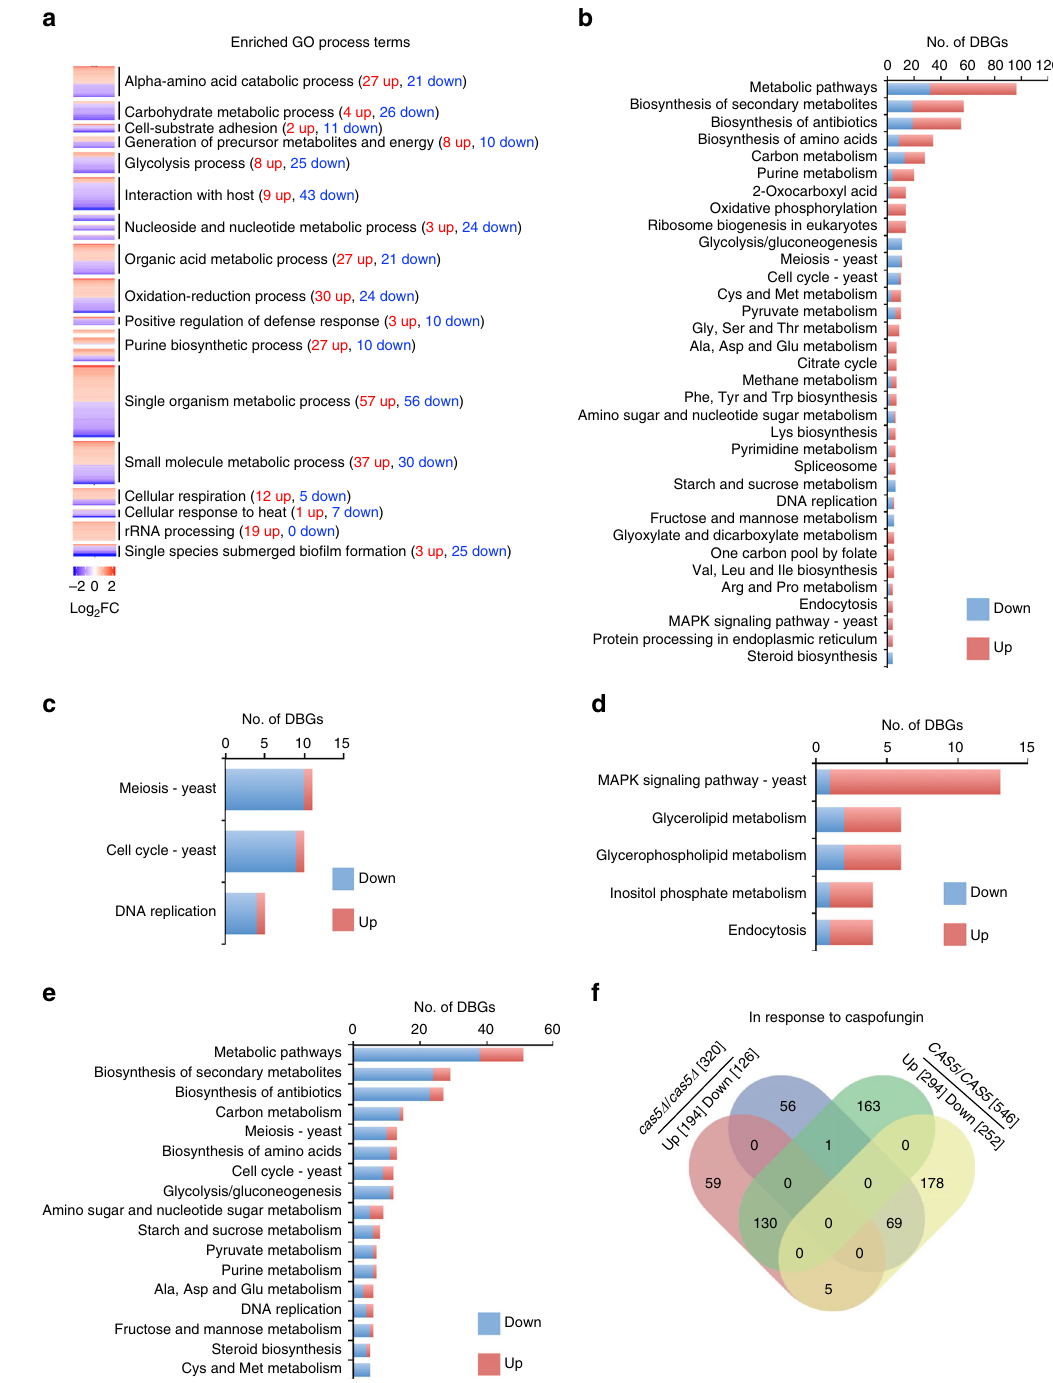
Fig. 1 Cas5 has a profound impact on RNA PolII binding at genes implicated in cell wall and cell cycle processes under both basal and cell wall stress conditions. a Heat maps showing the genes with increased ( red ) and decreased ( blue ) RNA PolII binding in a cas5 Δ /cas5 Δ mutant relative to wildtype. Enriched GO processes are indicated, and were clustered using the DAVID Gene Functional Classi fi cation Tool. b Bar chart showing the number of genes differentially bound by PolII ( DBGs differentially bound genes), with increased binding in red and decreased binding in blue , in a cas5 Δ / cas5 Δ mutant relative to wildtype based on their assigned KEGG pathways. KEGG pathways with four or more genes assigned are shown. c Bar chart showing the number of genes differentially bound by PolII, with increased binding in red and decreased binding in blue , in a cas5 Δ / cas5 Δ mutant relative to wildtype belonging to select KEGG pathways involved in cell cycle and related processes. d , e Bar charts showing the number of differentially bound genes involved in the indicated physiological pathways upon caspofungin treatment, with increased binding in red and decreased binding in blue , in a wild-type strain in response to caspofungin. KEGG pathways were grouped according to the ratio of genes with increased PolII binding to genes with decreased PolII binding in response to caspofungin, with d enriched for genes with increased PolII binding and e enriched for genes with decreased PolII binding. KEGG pathways with fi ve or more genes assigned are shown. f Venn diagram depicting number of genes differentially bound by RNA PolII in response to caspofungin in the wild-type reference (increased, green ; decreased, yellow ) and cas5 Δ /cas5 Δ mutant (increased, red ; decreased, blue ) strains. See Supplementary Data 1 – 4 for full data